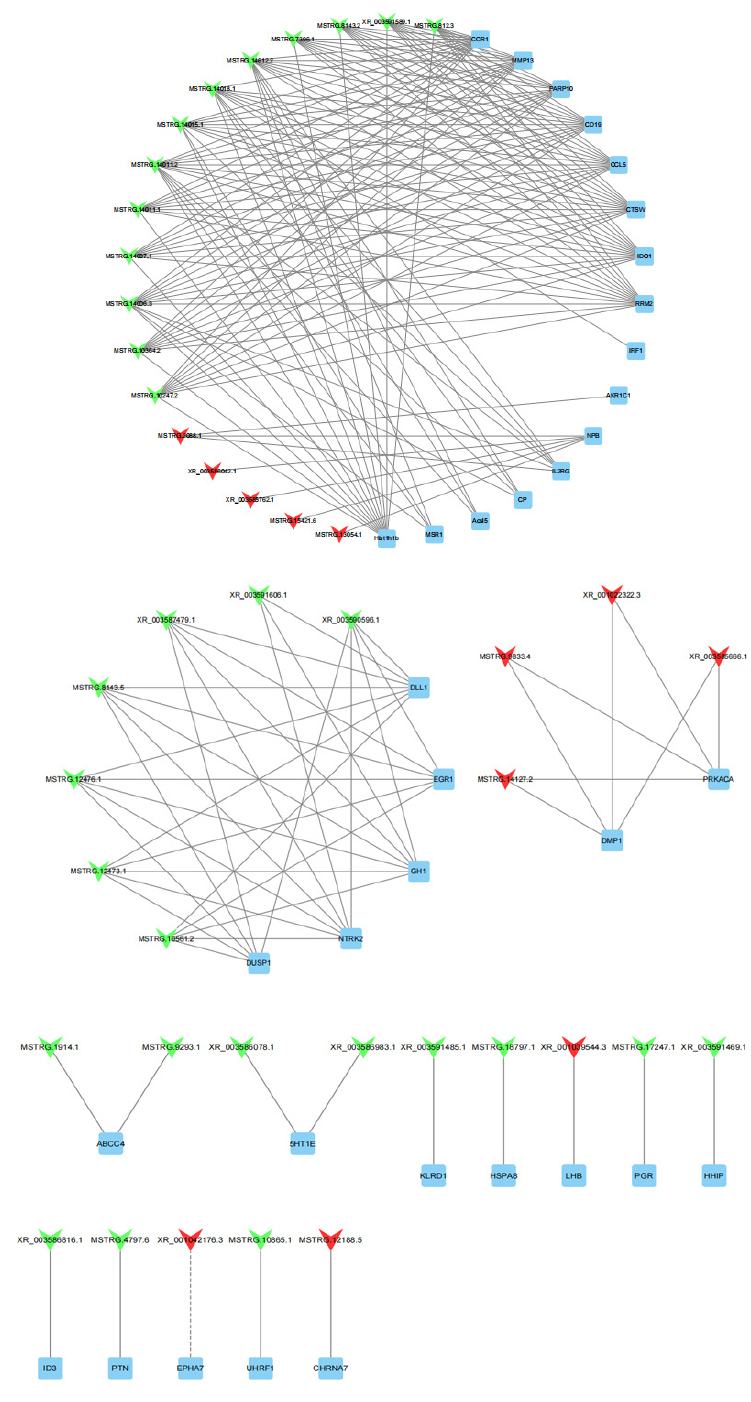
Figure 7. 43 DE lncRNAs and their 36 predictably interactive cis- and trans-targeted genes comprised this interactive network. The red and green colors represent up and downregulation, quadrilaterals represent lncRNA, the box represents targeted genes, the straight line and dotted line represent the interaction relationship of trans- and cis-regulation,